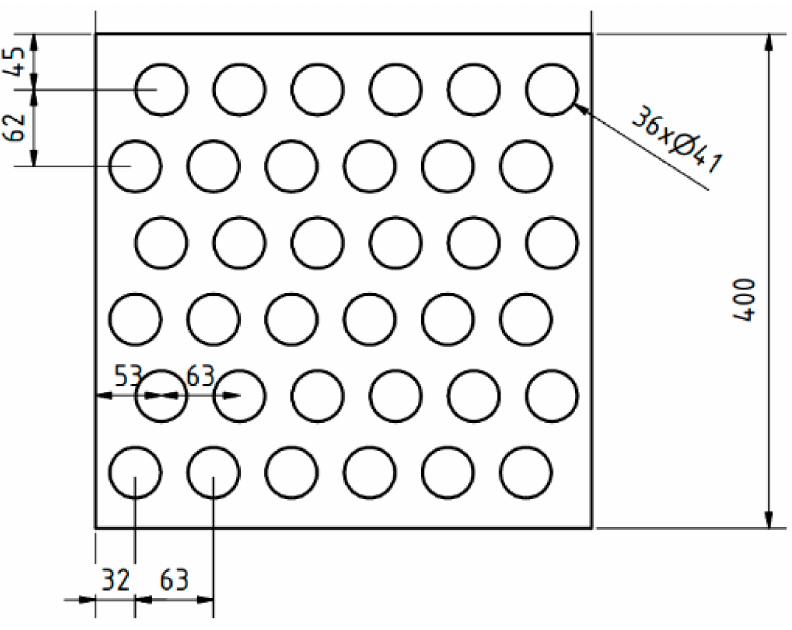
Figure 5. Final design of pipes arrangement.